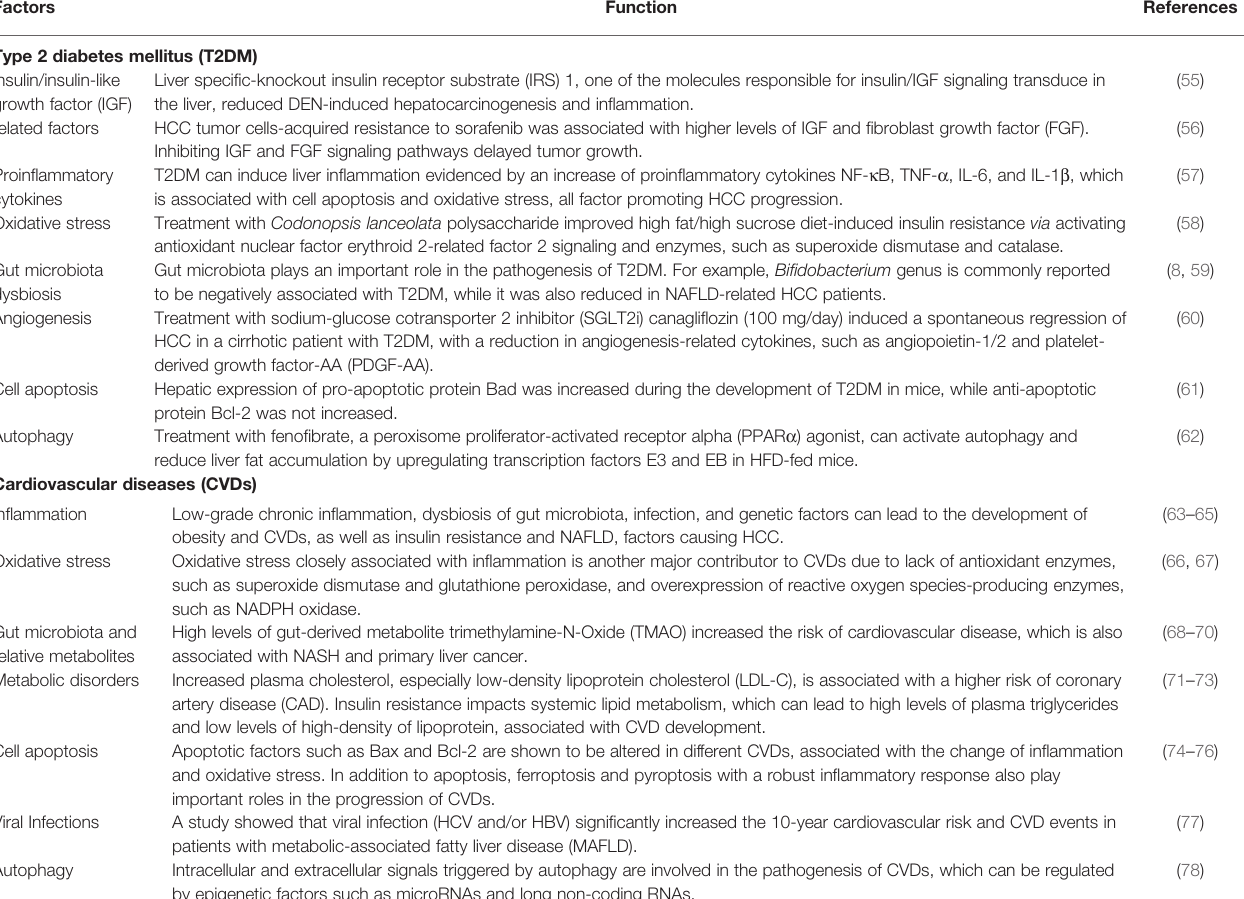
TABLE 1 | The underlying molecular mechanisms of HCC progression in T2DM patients or